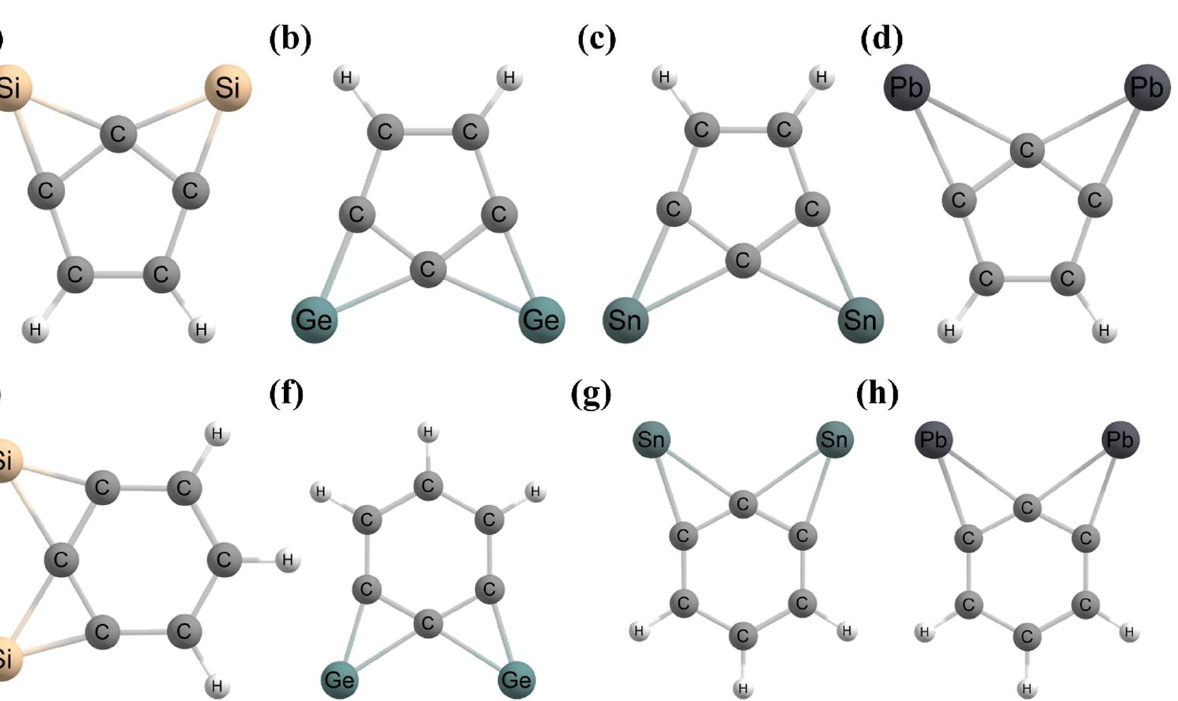
Figure 15. The optimized structures of cyclic aromatic hydrocarbons ( a ) Si 2 C 5 H 2 , ( b ) Ge 2 C 5 H 2 , ( c ) Sn 2 C 5 H 2 , ( d ) Pb 2 C 5 H 2 , ( e ) Si 2 C 6 H 3+ , ( f ) Ge 2 C 6 H 3+ , ( g ) Sn 2 C 6 H 3+ , and ( h ) Pb 2 C 6 H 3+ clusters.